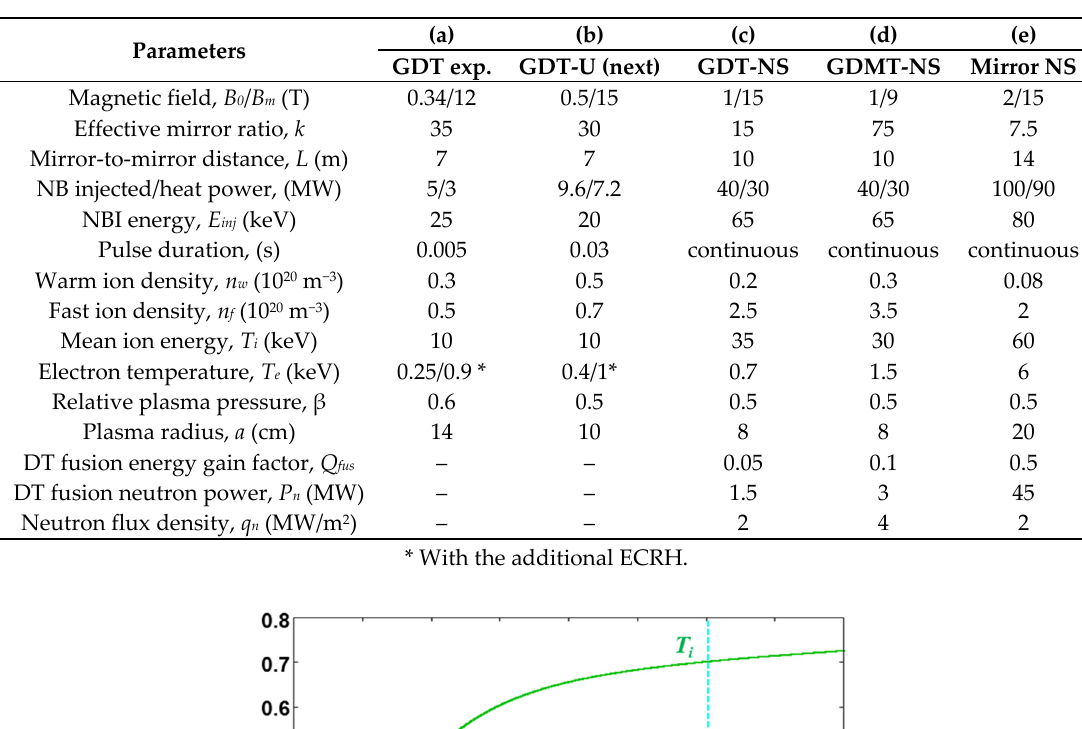
Table 1. Main results of neutron source simulations. (a) Achieved GDT experimental results; (b) GDT ‐ U project — a next step of the GDT experiments; (c) GDT ‐ based neutron source (GDT ‐ NS) proposed for fusion material research; (d) Gas ‐ Dynamic Multiple ‐ mirror Trap (GDMT); (e) Optimized mirror ‐ based NS.